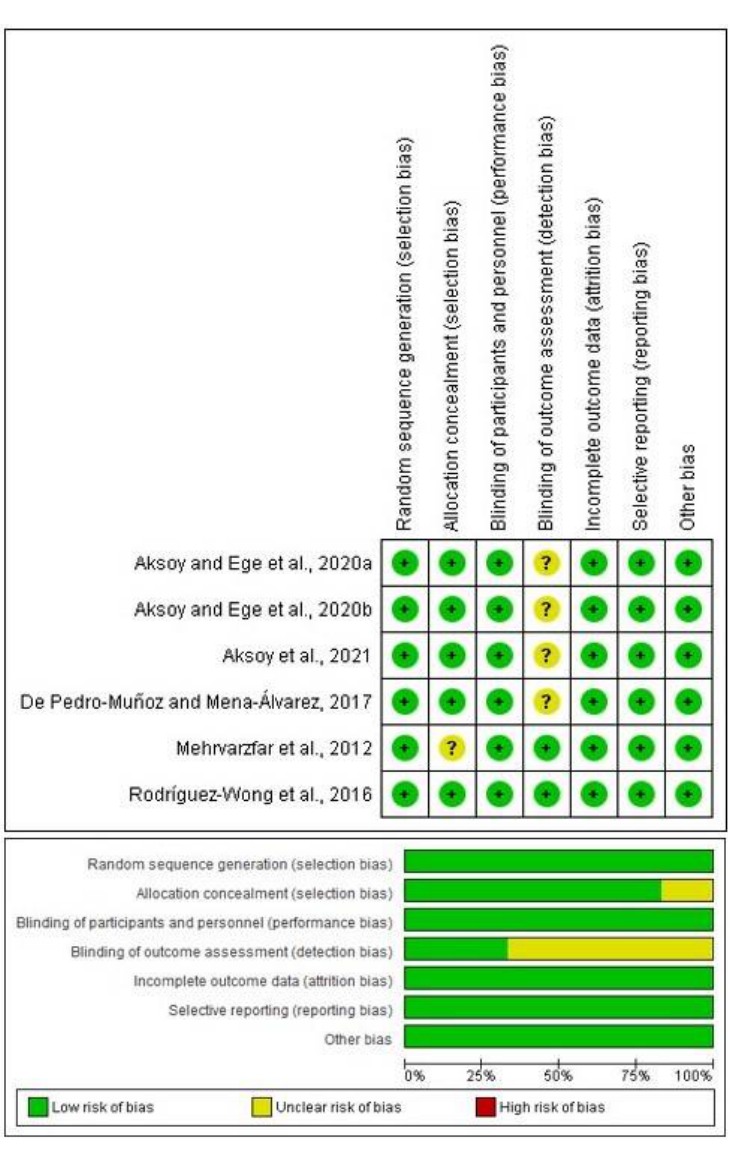
Figure 1. Study flow chart.